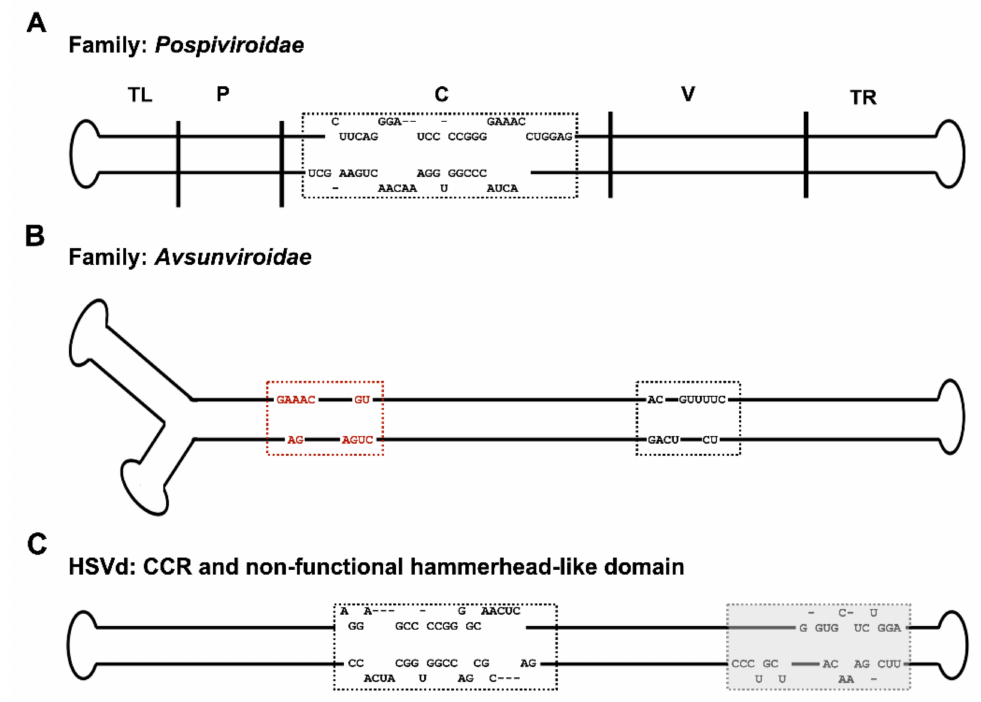
Figure 1. Structural differences among viroids. (Adapted from Adkar-Purushothama and Perreault, 2020 [66]). Primary and secondary structural characteristics considered for classification of viroids: ( A ) the PSTVd rod-like secondary structure comprising five functional domains is shown: the Terminal left (TL), Pathogenicity (P), Central (C), Variable (V) and Terminal right (TR) domains are separated by solid vertical lines. The nucleotide sequence of the central conserved region (CCR), a typical feature of the family, Pospiviroidae is shown within the box. ( B ) The ASBVd branched secondary structure is shown. Boxes represent the conserved nucleotides of the catalytic core within the hammerhead, a typical feature of the Avsunviroidae. The red and black boxes, respectively, indicate the hammerhead self-cleaving structures formed within the (+) and ( − ) strands. ( C ) The HSVd rod-like secondary structure is shown. The black-colored box represents the CCR while the shadowed box represents the non-functional hammerhead-like